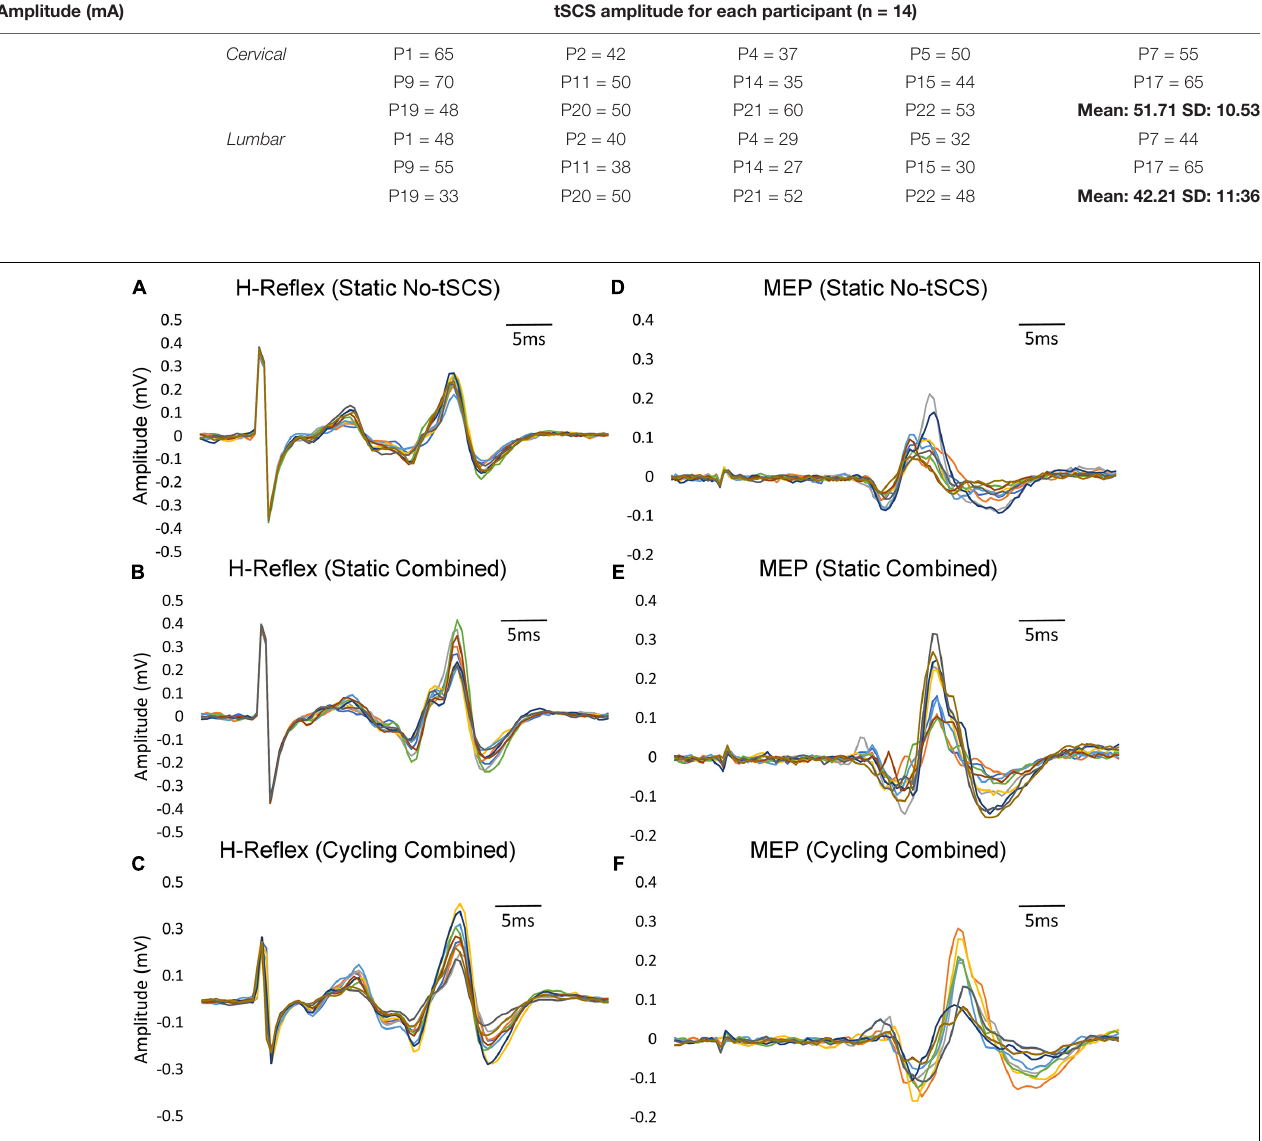
FIGURE 4 | Variability within individual participants. Examples of FCR H-reflex and MEP responses (10 sweeps) from an individual participant within a condition are provided. (A) Static H-reflexes evoked with No-tSCS. (B) Static MEPs evoked with No-tSCS. (C) Static H-reflexes evoked with Combined tSCS. (D) Static MEPs evoked with Combined tSCS. (E) Cycling H-reflexes evoked with Combined tSCS. (F) Cycling MEPs evoked with Combined tSCS.